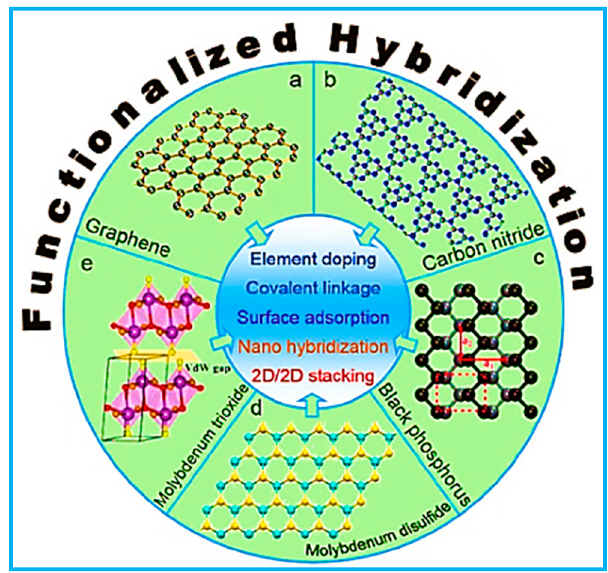
Figure 23. Functionalized hybridization of different 2D-materials through diverse strategies to combine various types of materials. Reprinted with permission from [428], Copyright 2019, Wiley-VCH.